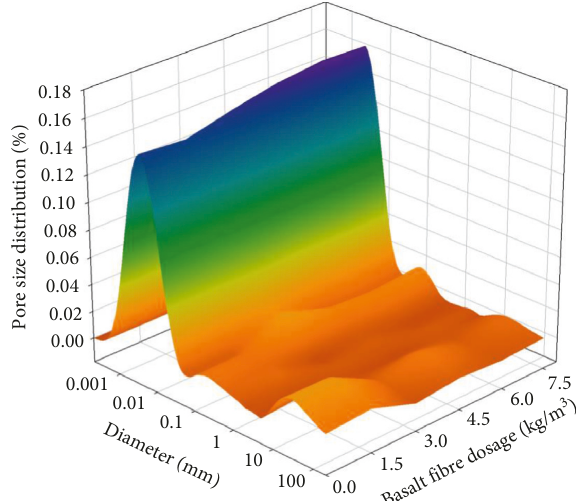
Figure 12: Pore size distribution at different fibre dosages.